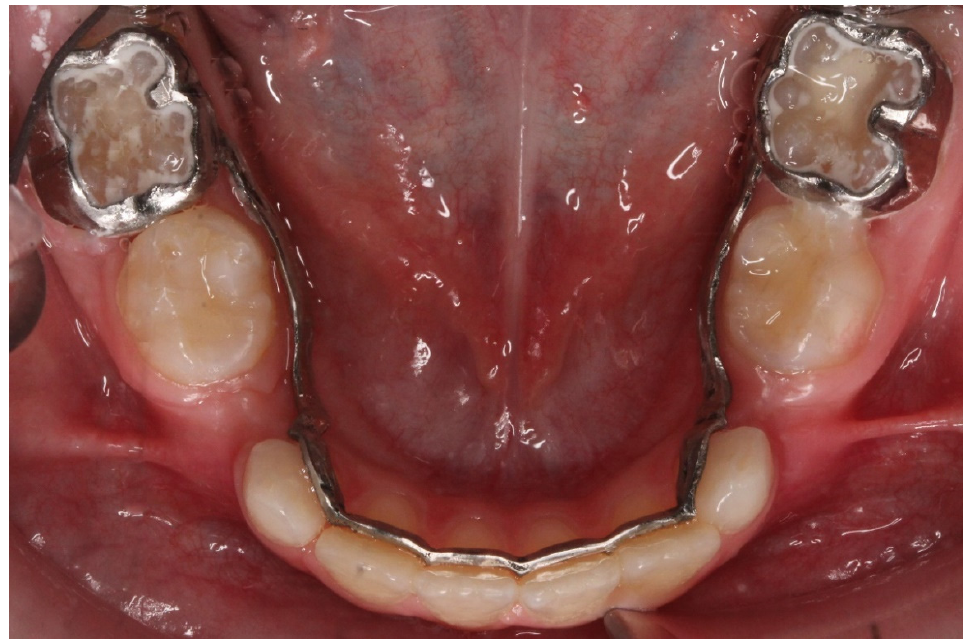
Figure 4. A lingual arch designed in Meshmixer and printed using CoCr alloy in SLS printer.